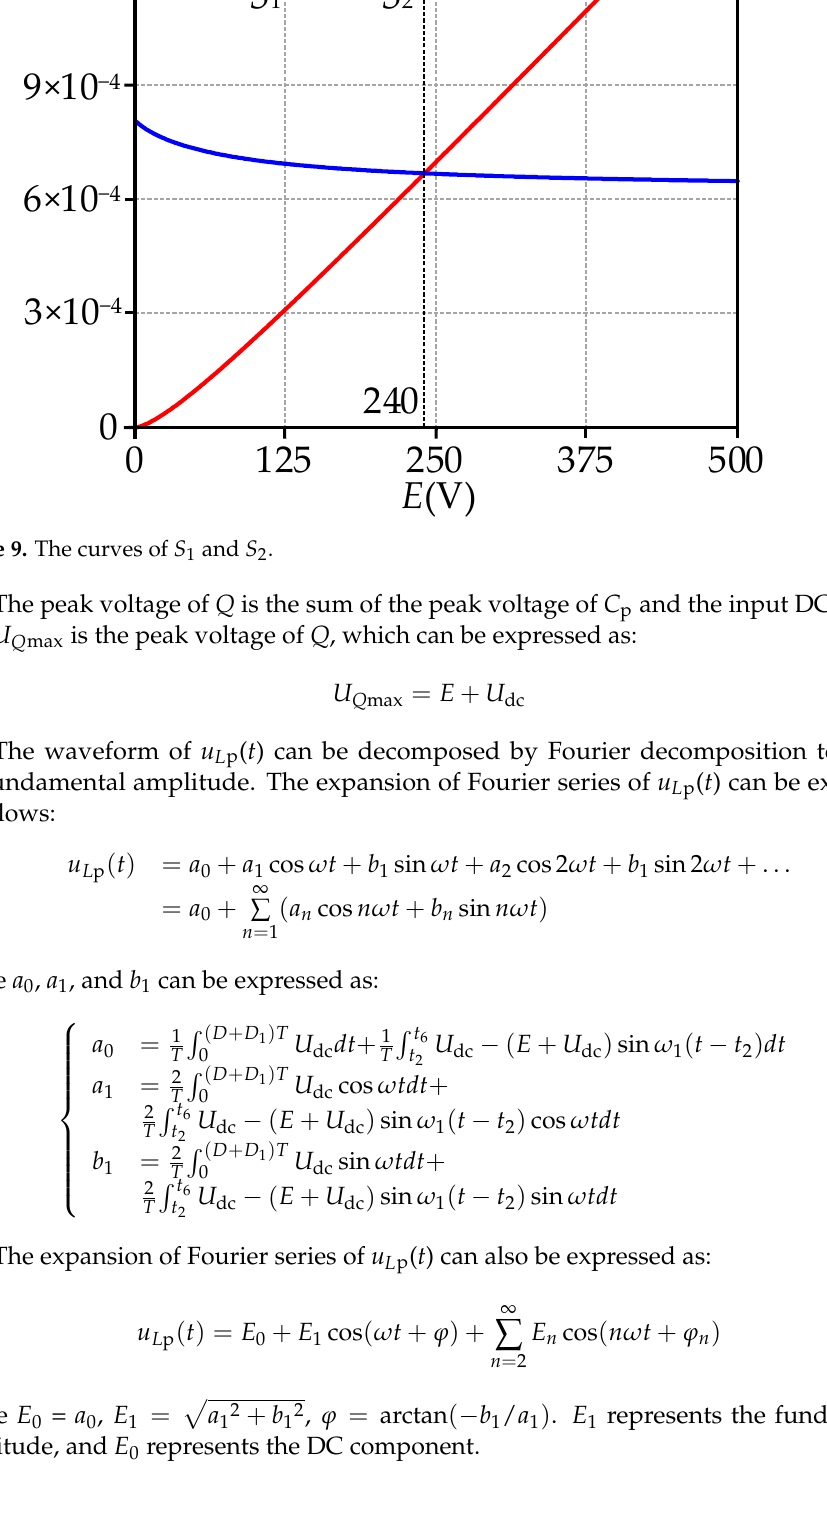
for the value of C p . According to the value of E , the coefficients of ∆ t , t 3 , and t 5 can also